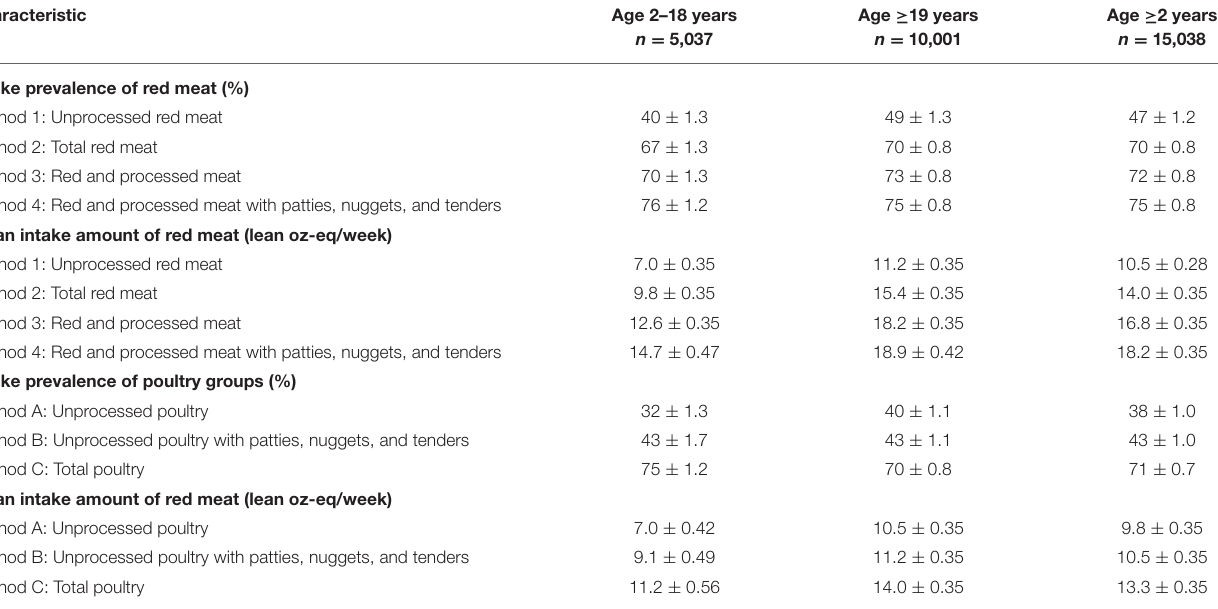
Weighted mean ± standard error of the mean. See Figure 1 for ontology of red meat and poultry method. Data source: US Centers for Disease Control and Prevention/National Center for Health Statistics, NHANES 2015–2018, day 1 dietary recall